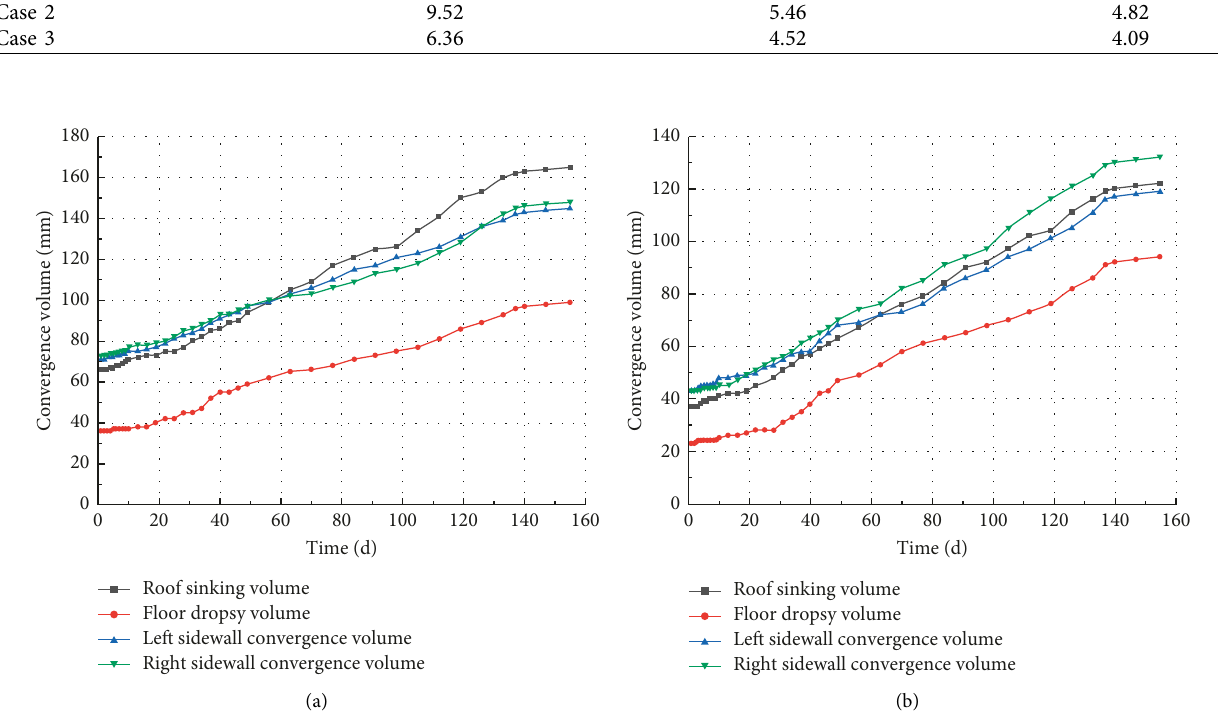
Figure 9: Convergence curve of measurement points at the return-air roadway: (a) measurement point 1 and (b) measurement point 2.